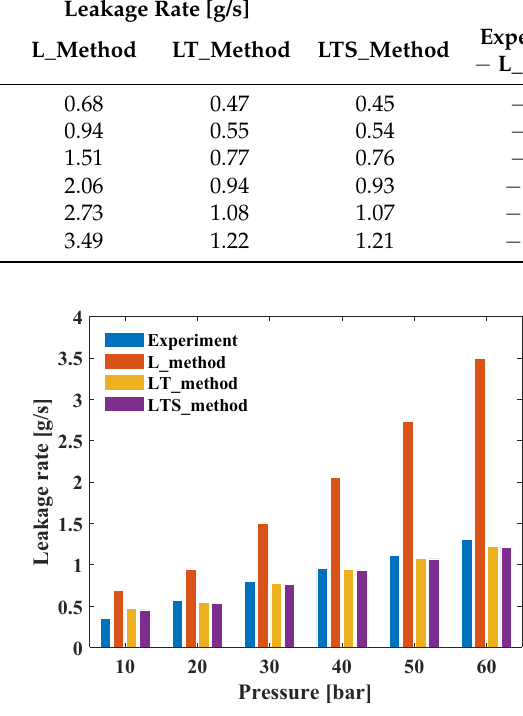
Figure 6. Experimental setup to measure leakage rate. Table 4. Measured and simulated leakage rate according to the change of the outer pressure.